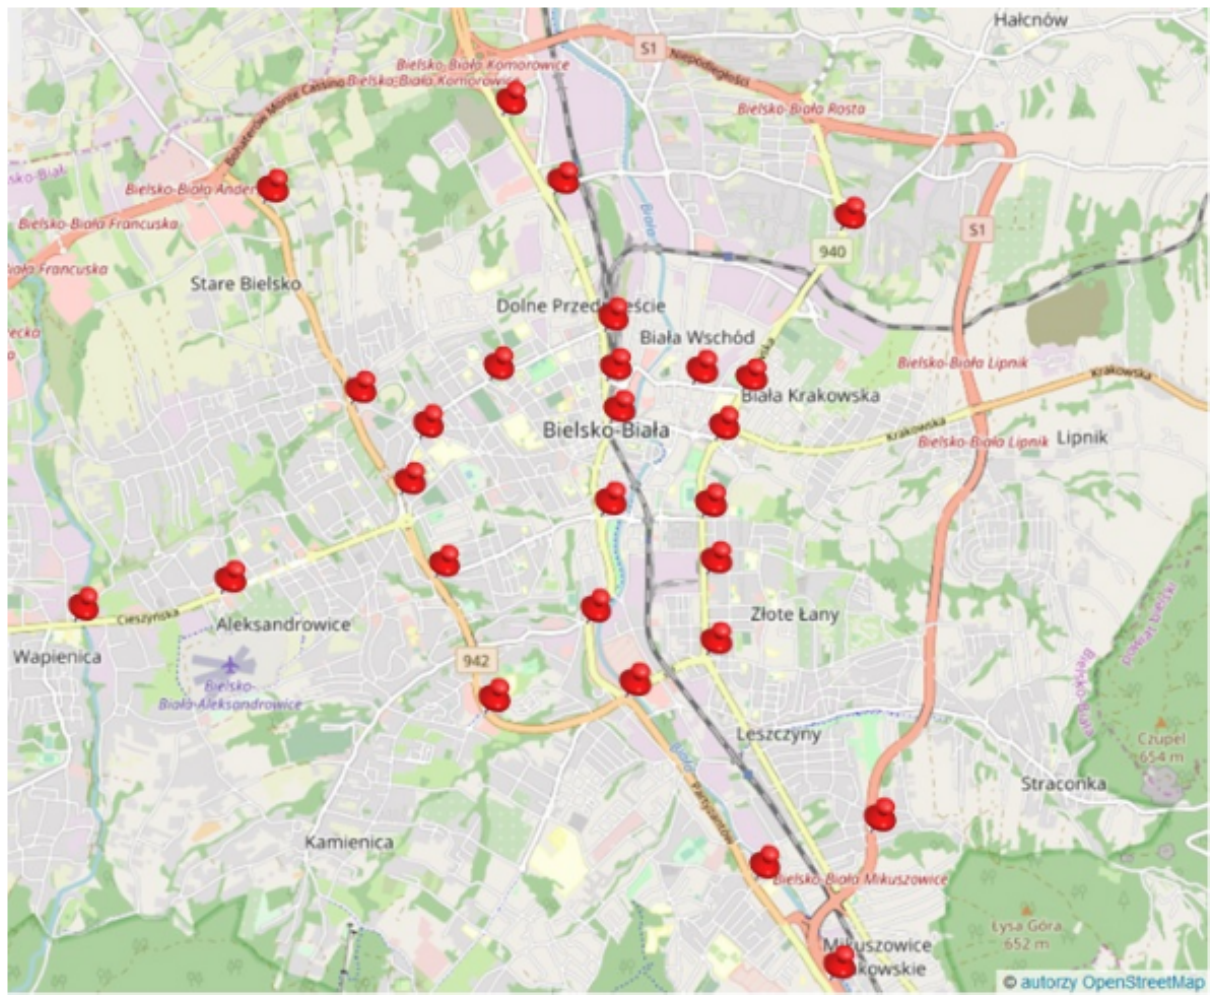
Figure 4: Location of Bluetooth WSN nodes in the Bielsko-Biala City road network (source: [14], graphic: https://www.openstreetmap.org, https://pl.freepik.com)